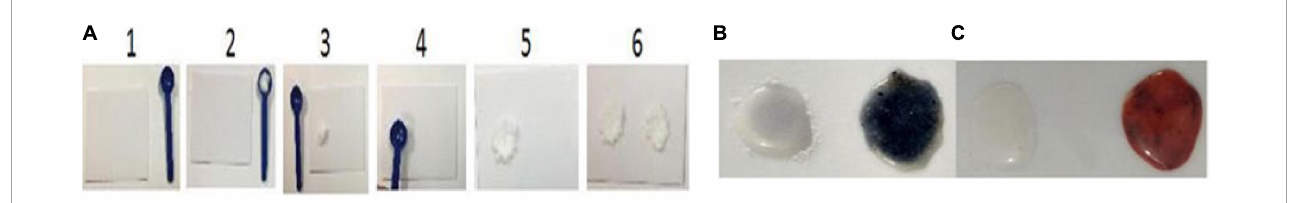
FIGURE1 Preparation of samples in steps (1-6) for the detection of iodine and iron (A) and validation of reagents for the analysis of iodine and iron, and sample preparation – Non-development and color development demonstrate the presence of iodine, and salt Iodine samples ( − ) and (+) ( B , blue), and iron and salt Iron samples ( − ) and (+) ( C , violet).